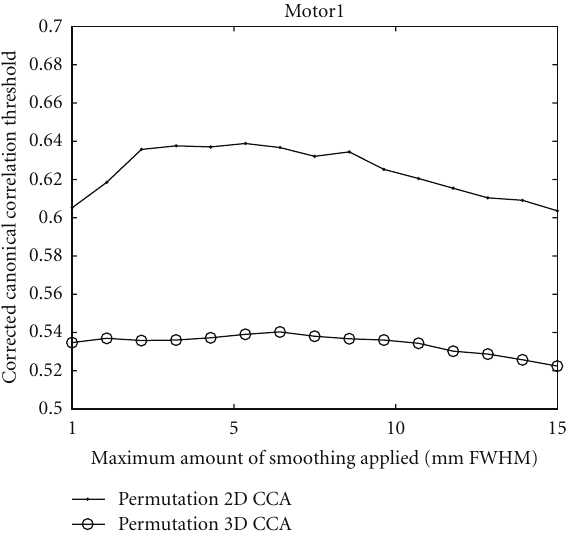
Figure 9: Canonical correlation thresholds, for corrected P = 0.05, as function of the maximum amount of smoothing that can be applied by CCA. The Motor 1 dataset was used.